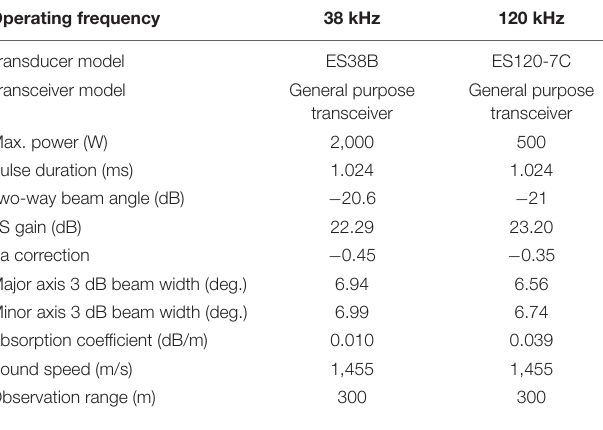
TABLE 1 | The parameters of transceiver calibrated for the acoustic